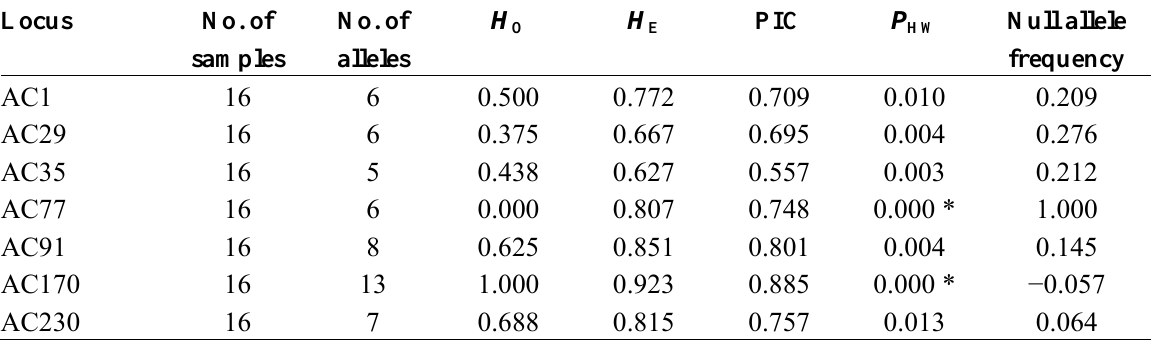
Table 2. Characterization of the twenty cross-species microsatellite loci in P. picticaudata . Locus No. of No. samples